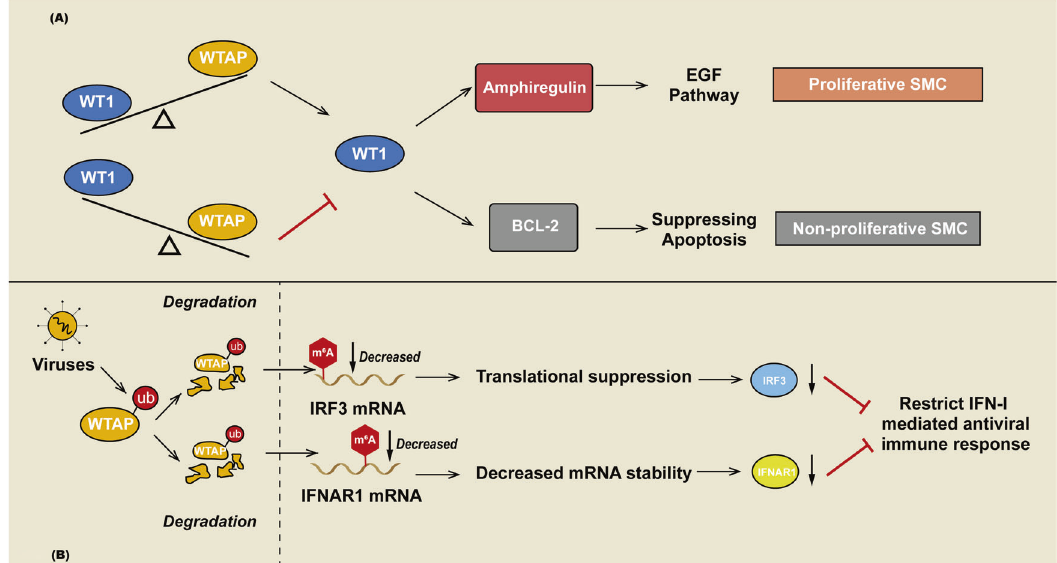
Fig. 3 A Model of the mechanism through which WTAP regulates SMC proliferation. The balance between WTAP and WT1 in fl uences the state of SMCs. When the expression of WTAP is reduced, WT1-mediated transcriptional events proceed. Amphiregulin is a direct transcriptional target of WT1 that drives SMC proliferation by upregulating the EGF pathway. Thus, SMCs switch to a proliferative state. When the balance of WTAP and WT1 is reversed, WT1-mediated transcription may be blocked, and the transcription of Bcl-2, which is suppressed by WT1, is activated. SMC apoptosis is increased, and the cells switch to a nonproliferative state. B WTAP in the antiviral immune response. WTAP is degraded in virus-infected cells. After viral infection, degradation of WTAP leads to a decrease in the m 6 A level of IRF3 mRNA and IFNAR1 mRNA, which leads to IRF3 mRNA translation blockade and accelerated IFNAR1 mRNA degradation. This biological process restricts the antiviral immune response and maintains downregulated the expression of MRP1 and P-gp and blocked ef fl ux pumps [120, 121]. Multidrug resistance-associated resistance to cisplatin [122, 123]. WTAP also upregulated the protein 1 (MRP1) and P-glycoprotein (P-gp) are two major expression of dual-speci fi city phosphatase 6 (DUSP6) by proteins in the ABC transporter family that prevent the cellular stabilizing its mRNA by increasing the m 6 A modi fi cation of its accumulation of chemotherapy drugs [122]. WTAP was upregulated in NKTCL cell lines. Depletion of WTAP transcript, which induced tumor progression and contributed